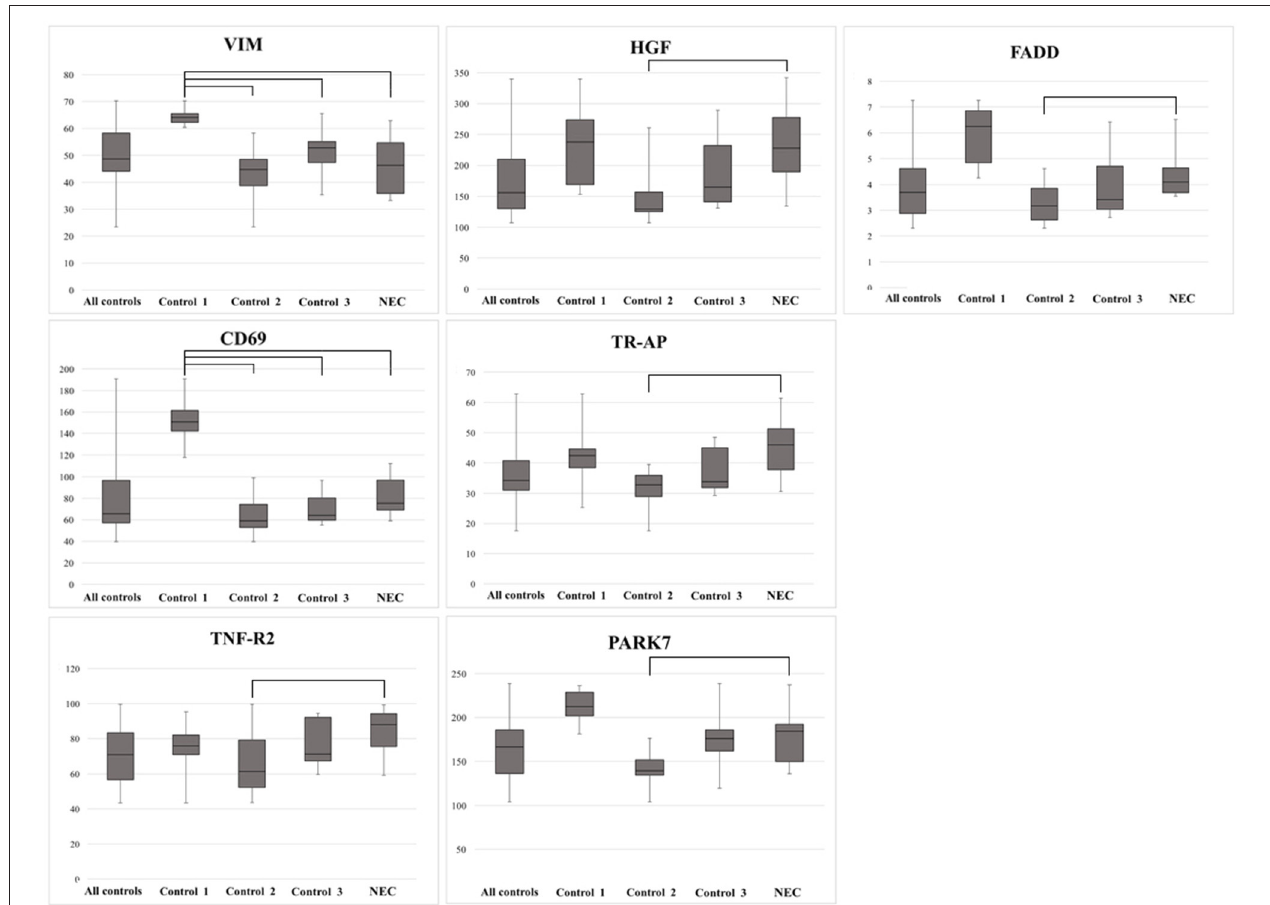
FIGURE 5 | Biomarkers previously reported linked to necrotizing enterocolitis (NEC) ( n = 7), and with the significant difference between Controls 1, 2, and 3 and the NEC group. Note the higher expression of VIM and CD69 in Control 1 compared with the NEC group, and the lower expression of TNF-R2, PARK7, FADD, HGF, and TR-AP in Control 2 compared with the NEC group. Bars depict significant